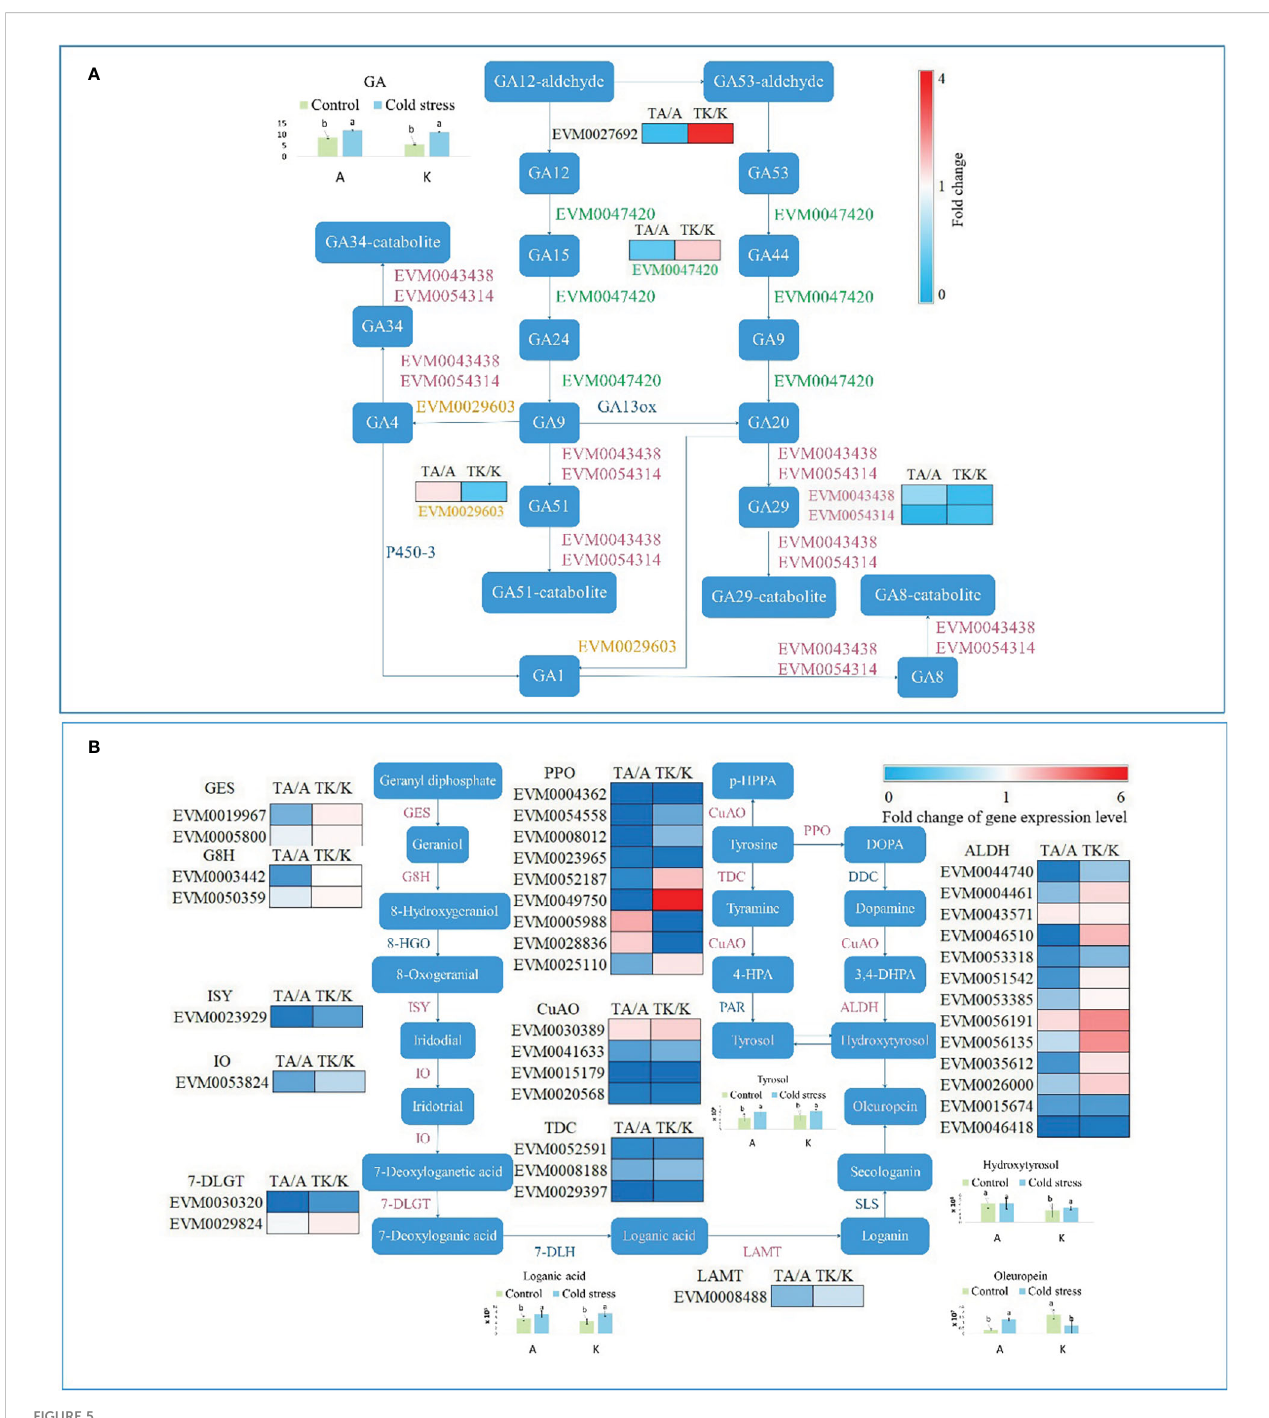
FIGURE 5 The terpene metabolism pathway affected by cold stress. (A) The diterpenoid biosynthesis pathway. (B) The oleuropein biosynthesis pathway. GES, geraniol synthase; G8H, geraniol 8-hydroxylase; 8-HGO, 8-hydroxygeraniol oxidoreductase; ISY, iridoid synthase; IO, iridoid oxidase; 7-DLGT, 7- deoxyloganetic acid-O-glucosyl transferase; 7-DLH, 7-deoxyloganic acid hydroxylase; LAMT, loganic acid methyltransferase; DDC, DOPA decarboxylase; SLS, secologanin synthase; PPO, polyphenol oxidase; TDC, tyrosine decarboxylase; CuAO, primary amine oxidase; PAR, phenylacetaldehyde reductase; ALDH, alcohol dehydrogenase. ‘ A ’ and ‘ K ’ represent Arbequina and Koroneiki under normal conditions; ‘ TA ’ and ‘ TK ’ represent Arbequina and Koroneiki under cold conditions; ‘ a ’ and ‘ b ’ represent signi fi cant difference based on least signi fi cant difference